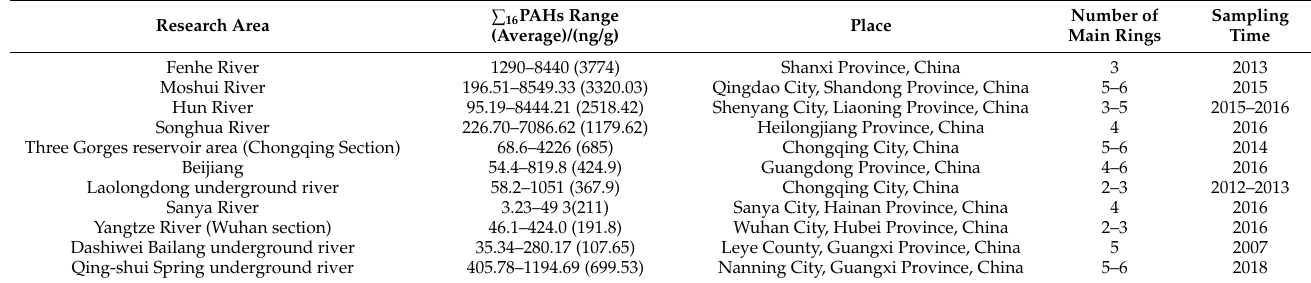
Table 4. Comparison of concentrations of ∑ 16 PAHs in surface sediments from different research areas. Research